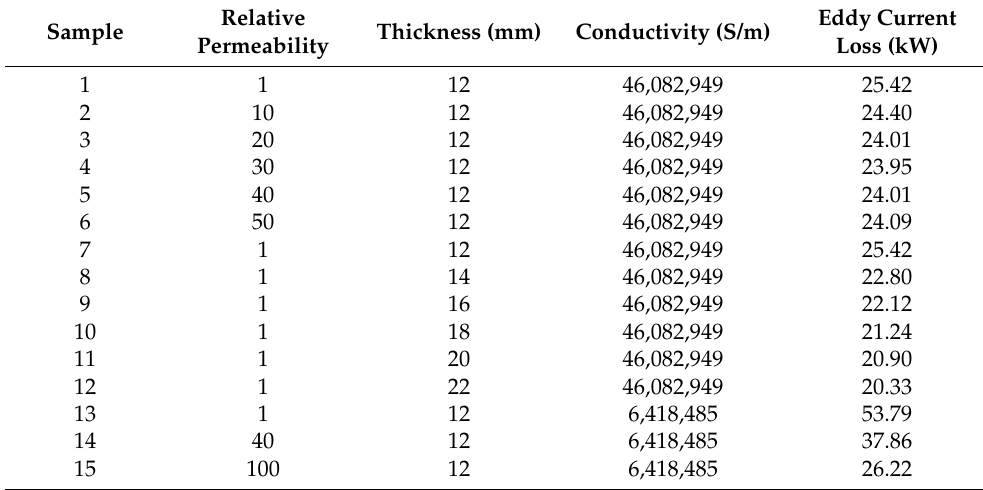
Table 3. The training sample sets of eddy current